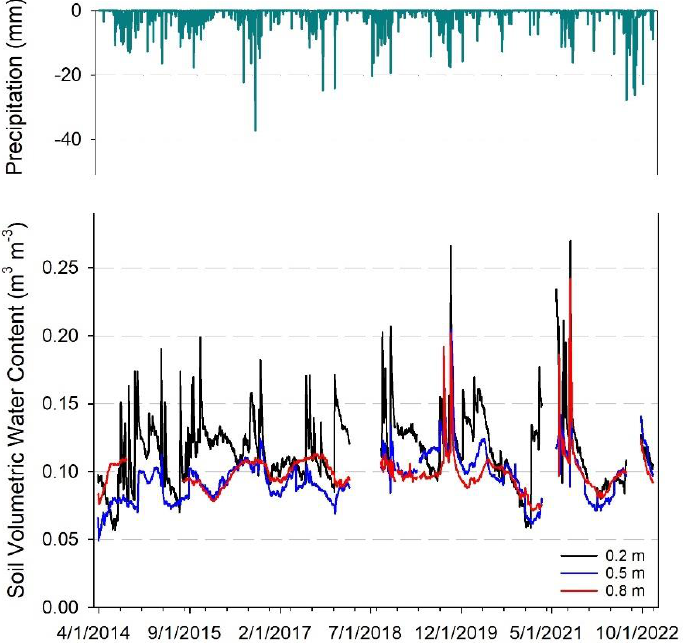
Figure 3. Daily precipitation and daily-average soil volumetric water content ( θ ) for all sensors at each of 0.2, 0.5, and 0.8 m depths from 26 March 2014 to 2 December 2022. The North station θ levels ranged from 0.052 to 0.214 for the 0.2 m sensor depth, from 0.029 to 0.189 for the 0.5 m depth, and from 0.076 to 0.125 for the deeper 0.8 m sensor depth. The South station θ levels ranged from 0.026 to 0.296, from 0.051 to 0.272, and from 0.051 to 0.242 for the 0.2, 0.5, and 0.8 m depths, respectively. A closer look at the relationships between P and θ can be observed in Figure 4, which depicts daily P and θ level variability spanning three summer seasons (2015 to 2017) for the North soil water station. A sharp rise and decline in θ can be observed for the sensor at the 0.2 m depth. A less pronounced, steadier rise that generally peaked between July and August for the 0.5 m sensor and between September and October for the 0.8 m sensor was noted for most years. A storm event in October 2016 resulted in a significant rise in θ levels for the 0.5 m sensor. The higher θ levels observed at 0.8 m than at 0.5 m were at- tributed to finer-textured soil, which consequently increased water holding capacity, noted at that depth during sensor installation. The ANOVA results showed no statistical difference ( p > 0.05) in θ levels between the two sensors installed at 0.2 m and between the two sensors at 0.5 m in each soil water station for either the dry or wet season every year. A significant difference ( p ≤ 0.05) in mean θ levels for dry vs. wet seasons was found for each sensor depth (0.2 and 0.5 m) within each station and between stations. No comparison was performed for the 0.8 m depth. Figure 4. Daily precipitation ( P ) and soil volumetric water content ( θ ) levels at 0.2, 0.5, and 0.8 m depths at the North station from 1 May 2015 to 31 March 2017.